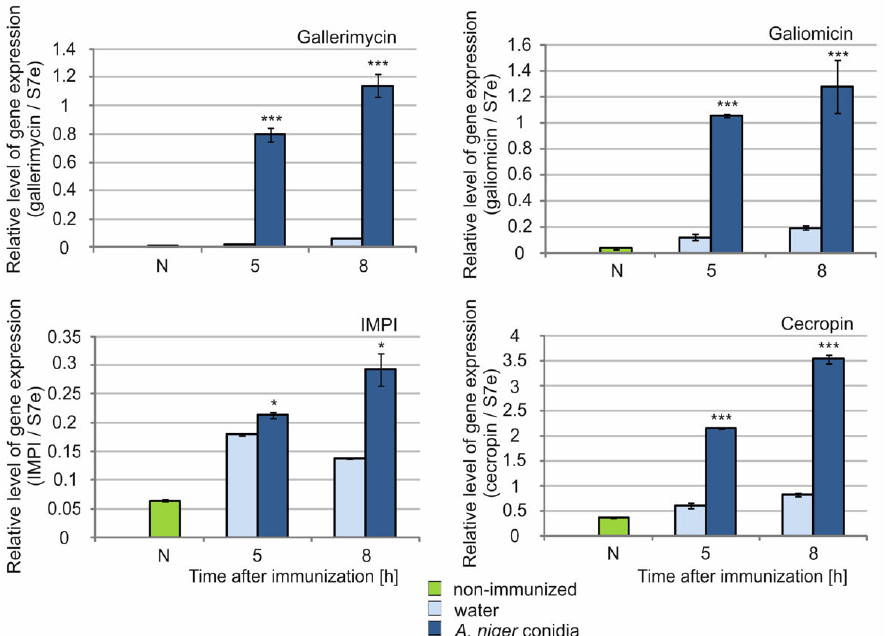
Figure 7. Expression of genes of selected defense peptides in the fat body of G. mellonella larvae after immunization with A. niger conidia. The level of expression of gallerimycin, galiomicin, IMPI, and cecropin genes was tested in the fat body of non-immunized larvae (N) and 5 h and 8 h after immunization with A. niger conidia (1 × 10 5 ) and water (control) using real time qPCR as described in the Materials and Methods. Statistically significant differences between the mean values obtained at the respective times after immunization with conidia and water are marked with asterisks: * p < 0.05, *** p ≤ 0.001.